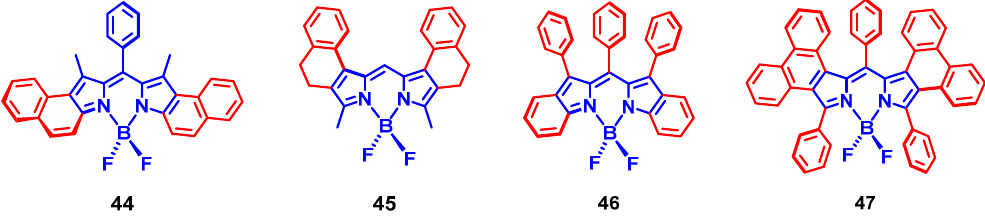
Figure 14. Bodipy derivatives with molecular structure of twisted π -conjugation framework.